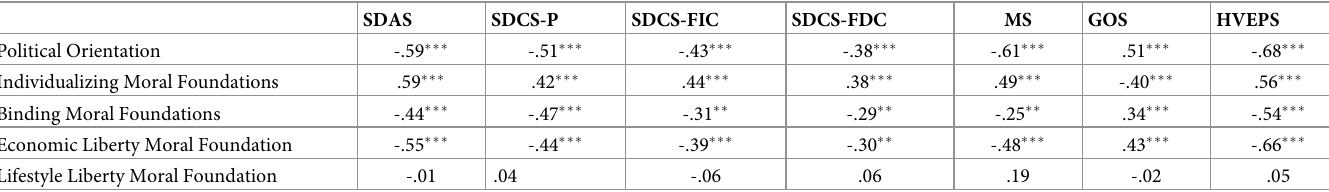
Table 8. Correlation matrix for political, moral, and social distancing outcome measures in American sample (n =